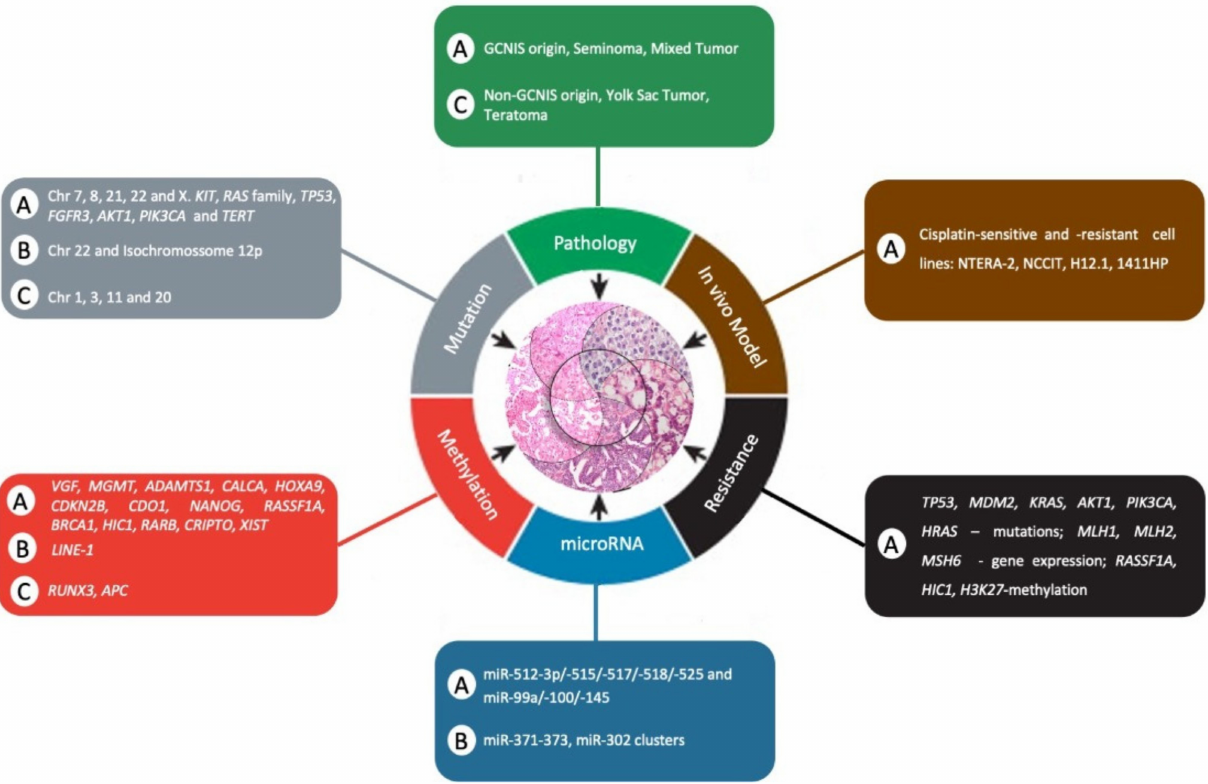
Figure 2. Comparison of clinical and molecular differences between adult and pediatric patients with TGCTs as a hallmark of cancer. The letter “A” represents adults, “C” represents child, and “B” represents both adult and child. Adapted from Hanahan and Weinberg